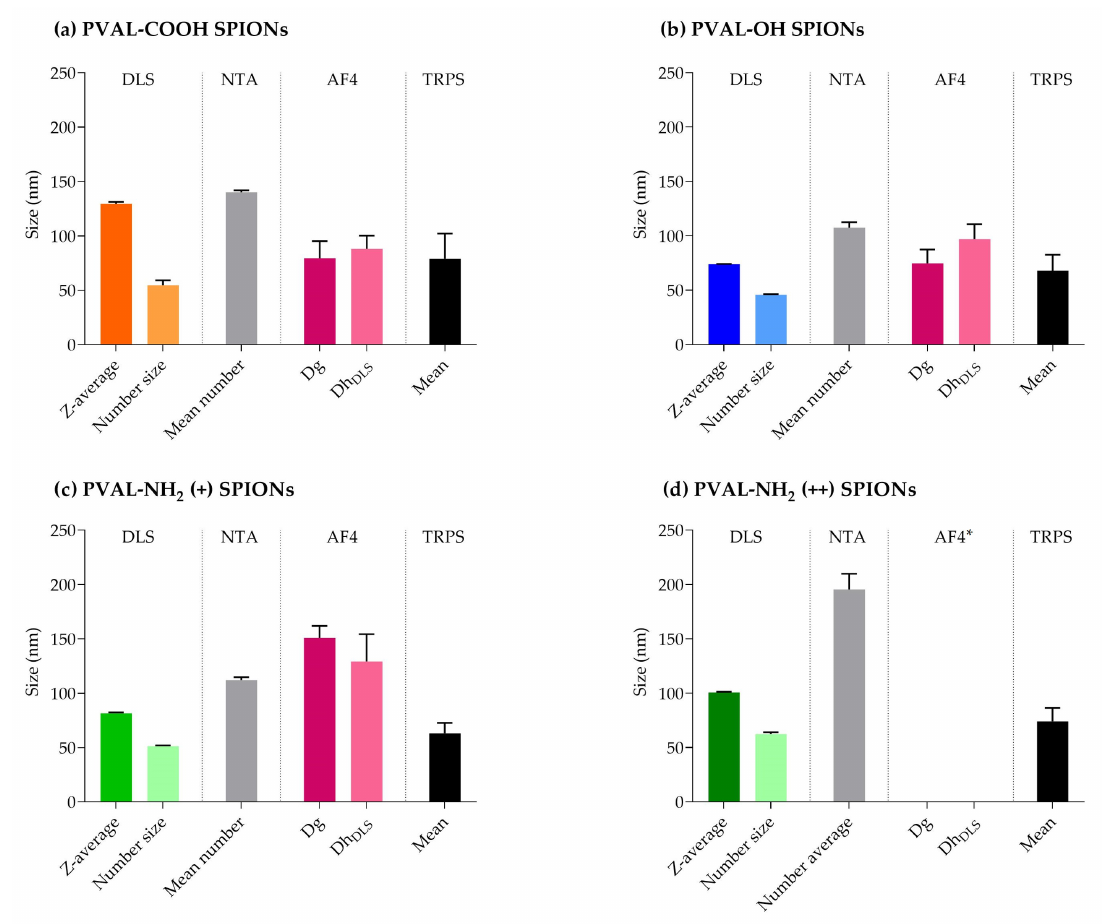
Figure 6. Summary of the average sizes obtained by different sizing techniques. ( a ) PVAL-COOH Figure 1. Example of a network map, in this case for the MO Lomingo e.V. SPIONs, ( b ) PVAL-OH SPIONs, ( c ) PVAL-NH 2 (+) SPIONs and ( d ) PVAL-NH 2 (++) SPIONs. * Data not available due to the high interaction between PVA-NH 2 (++) SPIONs and the amphiphilic regenerated cellulose MO, (2) state actor, (3) welfare organization, (4) association/initiative/center, (5) religious